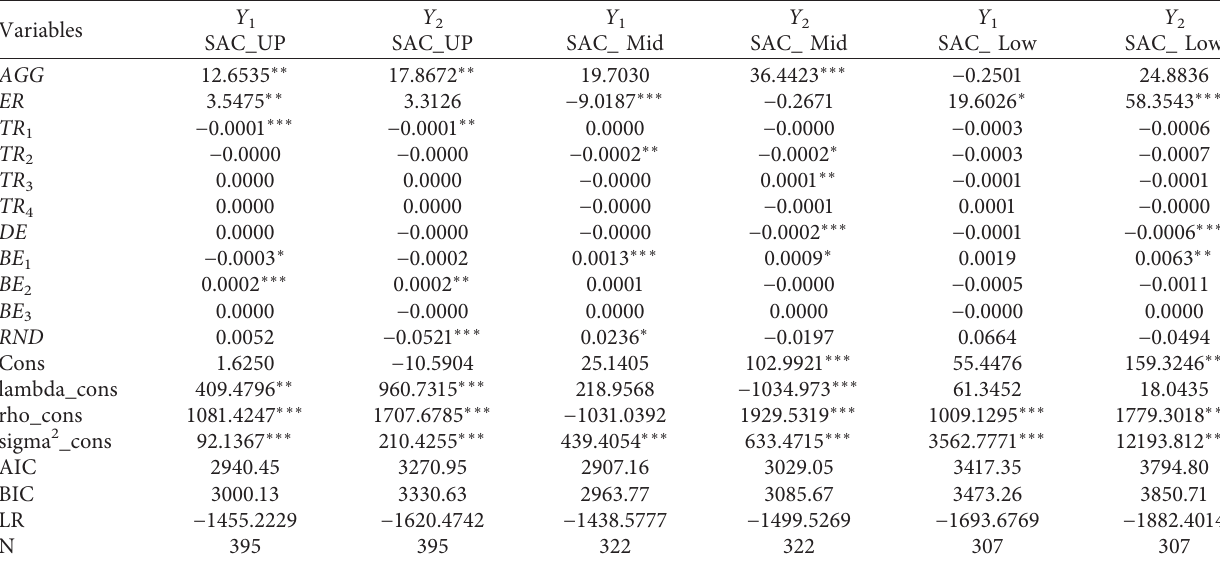
Table 5: SAR model results for typical regions, 1998–2005.